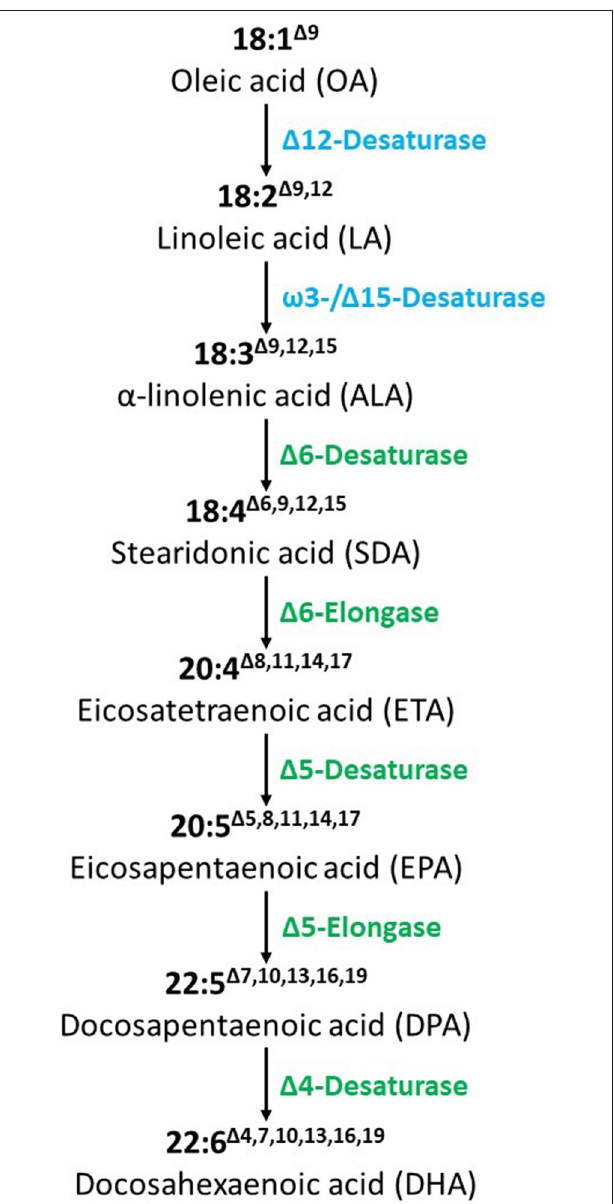
FIGURE 1 | Biosynthesis of DHA from OA in DHA canola. The synthesized genes coding for these enzymes based on yeast (blue) or algal (green) sequences were constructed in a T-DNA vector under the control of seed-specific